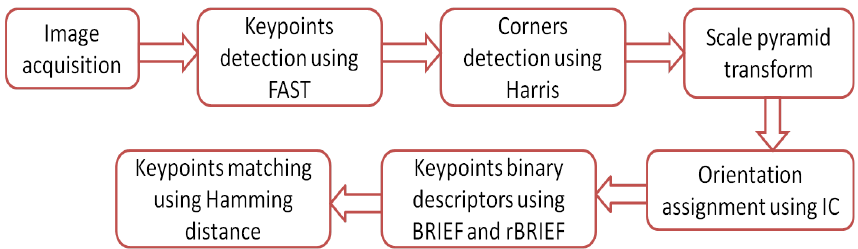
Figure 10. Flow chart for the ORB